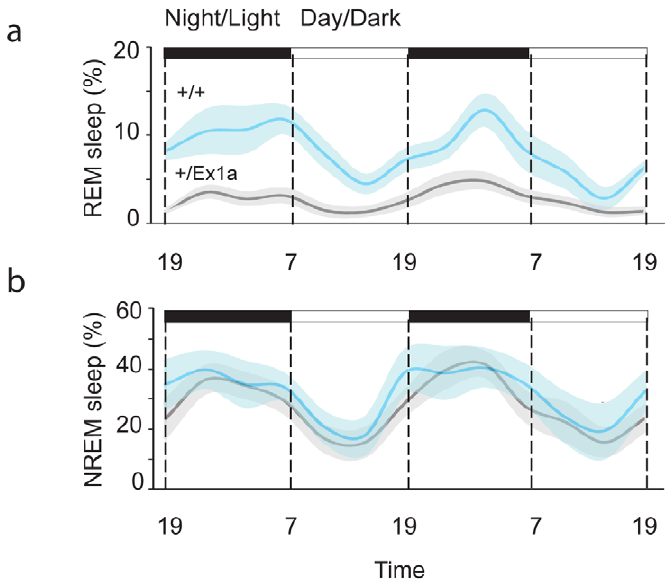
Figure 2. Sleep architecture in Exon 1A mice. Four-hour bins percentage and 6 s.e.m., shadowed, of REM (a) and NREM (b) sleep for a 48-hour period.